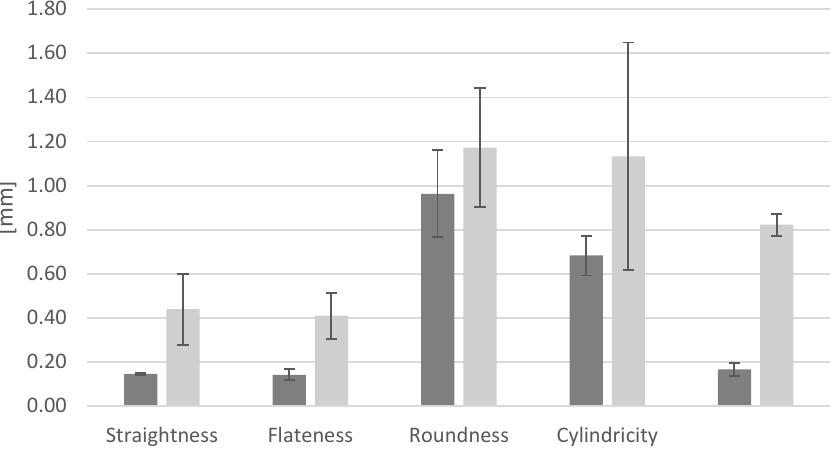
Figure 6. Comparison of the determined form tolerance values of different Lego bricks scanned by Artec space spider and the iPad Pro (2020) using TrueDepth.